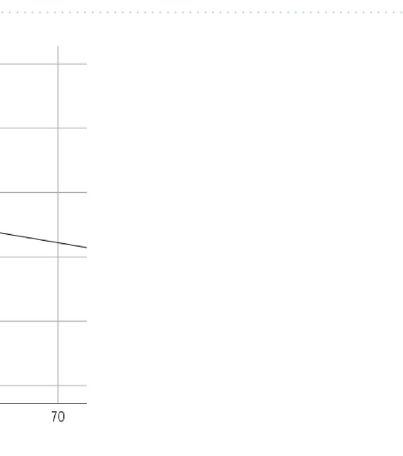
Table 4. Partial correlations. n = 417; *p < 0.05; **p < 0.01; ***p < 0.001. ☨ p < 0.05 for multiple comparisons using the Benjamini and Hochberg method. The figures are controlled for age, sex, BMI, knowledge work, institute, and GM-BHQ for SHS. The figures are controlled for sex, BMI, knowledge work, institute, and GM-BHQ for age. The numbers in parentheses are the ones when income is added to the control.